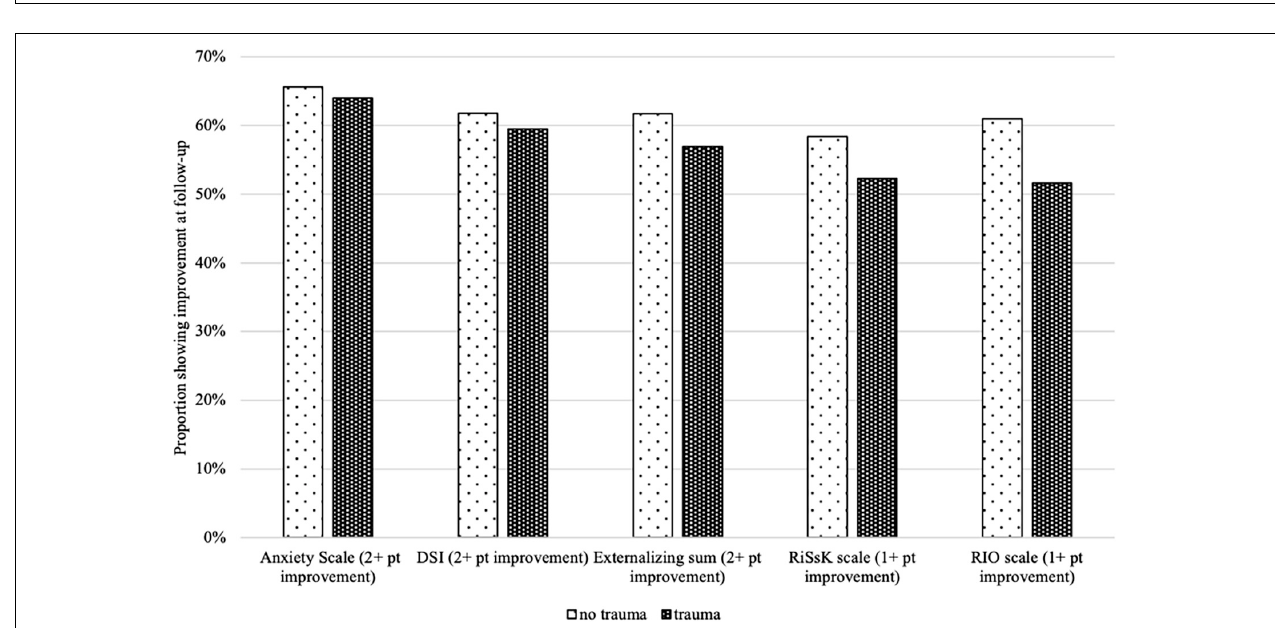
FIGURE 3 | Percentage distributions of Depressive Severity Index score of 4 or greater, by trauma and instrument.